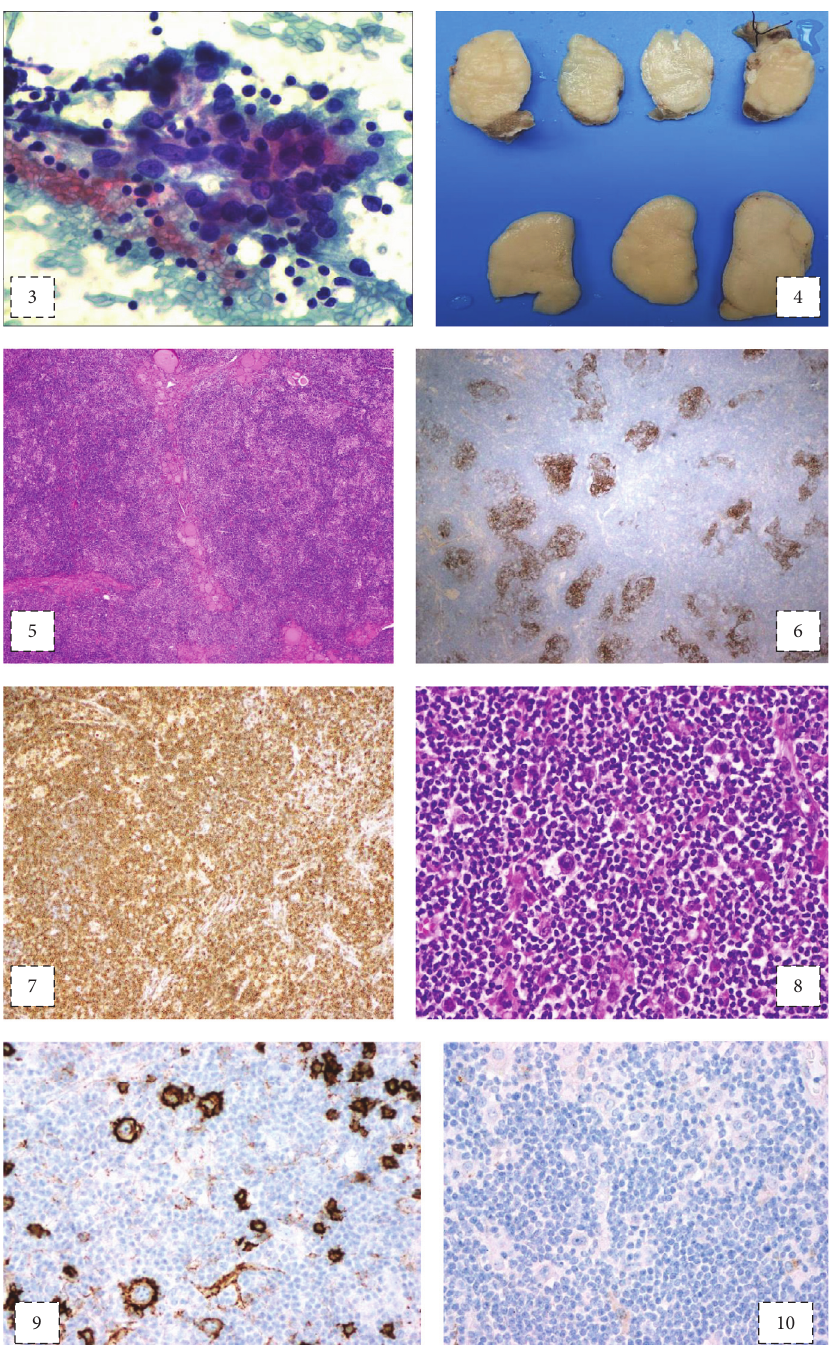
Figure 2: 3: FNA of the thyroid with follicular cells with suspicious nuclei (anisokaryosis, longitudinal grooves) on the background of a lymphocytic thyroiditis (Papanicolaou stain, 400x); 4: macroscopy features of the surgical specimens: left hemithyroidectomy (on top) and left cervical lymph node (on the bottom); 5: thyroid parenchyma with a diffuse infiltration of a lymphoid neoplasm (HE, 40x). These features were also found on the lymph node (not shown); 6: the neoplasm consisted of irregular nodules of follicular dendritic cells (CD21, 40x); 7: extensive background of CD4+ T-lymphocytes (CD4, 40x); 8: intermingled scattered large “popcorn cells” could be observed (HE, 200x); 9: the neoplastic popcorn cells were positive for CD20 (CD20, 200x); 10: they were negative for CD30 (CD30, 200x) and CD15 (not